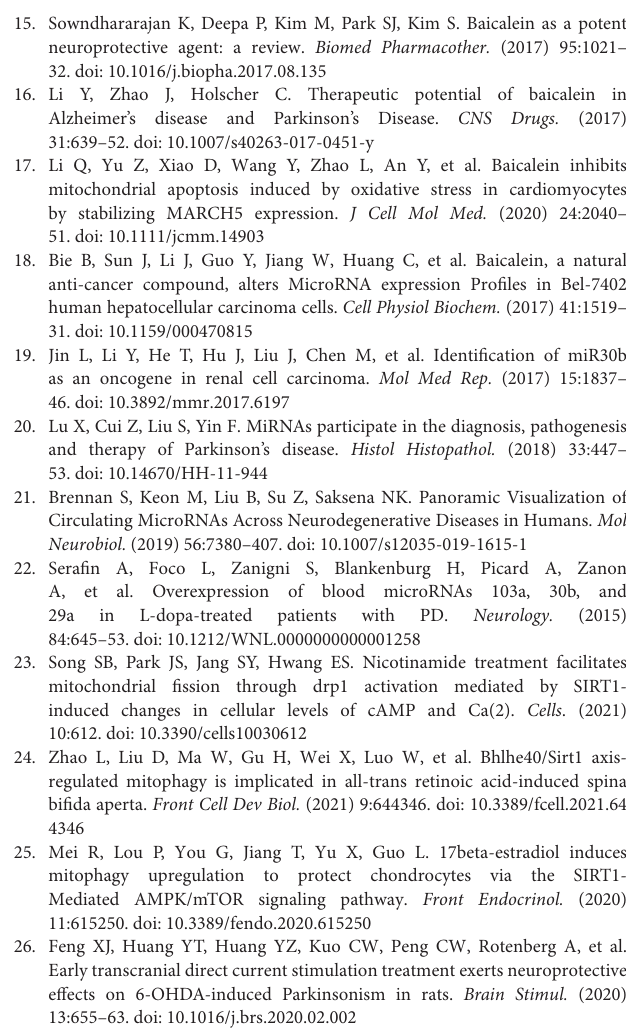
Figure S1 | Baicalein played a protective role in the PD rat model. PD model operation was performed in SD rats, and the protective effect of baicalein on PD rats was observed after baicalein treatment. (A) Neurological score; (B) DA content was detected by HPLC-EC; (C) apoptosis was detected by TUNEL staining; (D) neuronal degeneration was detected by Fluoro-Jade B staining. N = 6. The data in the figure are all measurement data and expressed as mean ± standard deviation; one-way ANOVA was used for variance analysis; Tukey’s multiple comparisons test was used for the post hoc test. ∗∗∗ p <